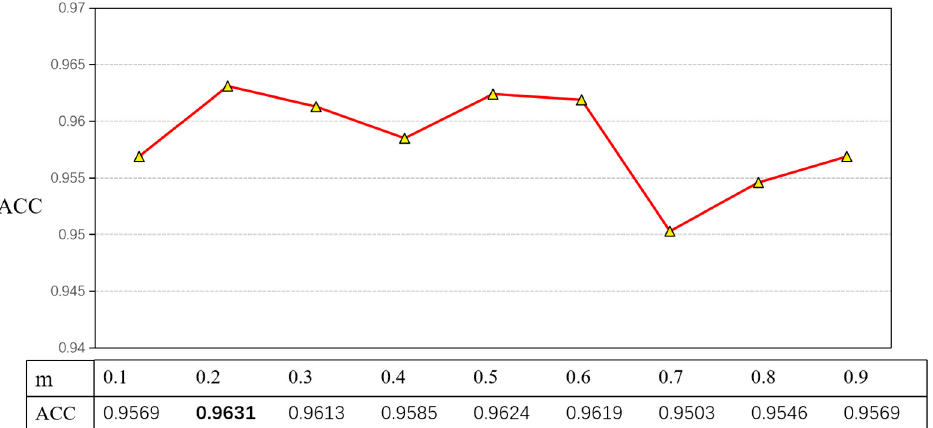
Figure 11. Testing the relationship between m and accuracy when GCN-layer = 1 and dropout = 0.1. The ACC reached the highest value of 0.9631. This was 0.07 higher than other values. The bolded font in the figure is the optimal effect.